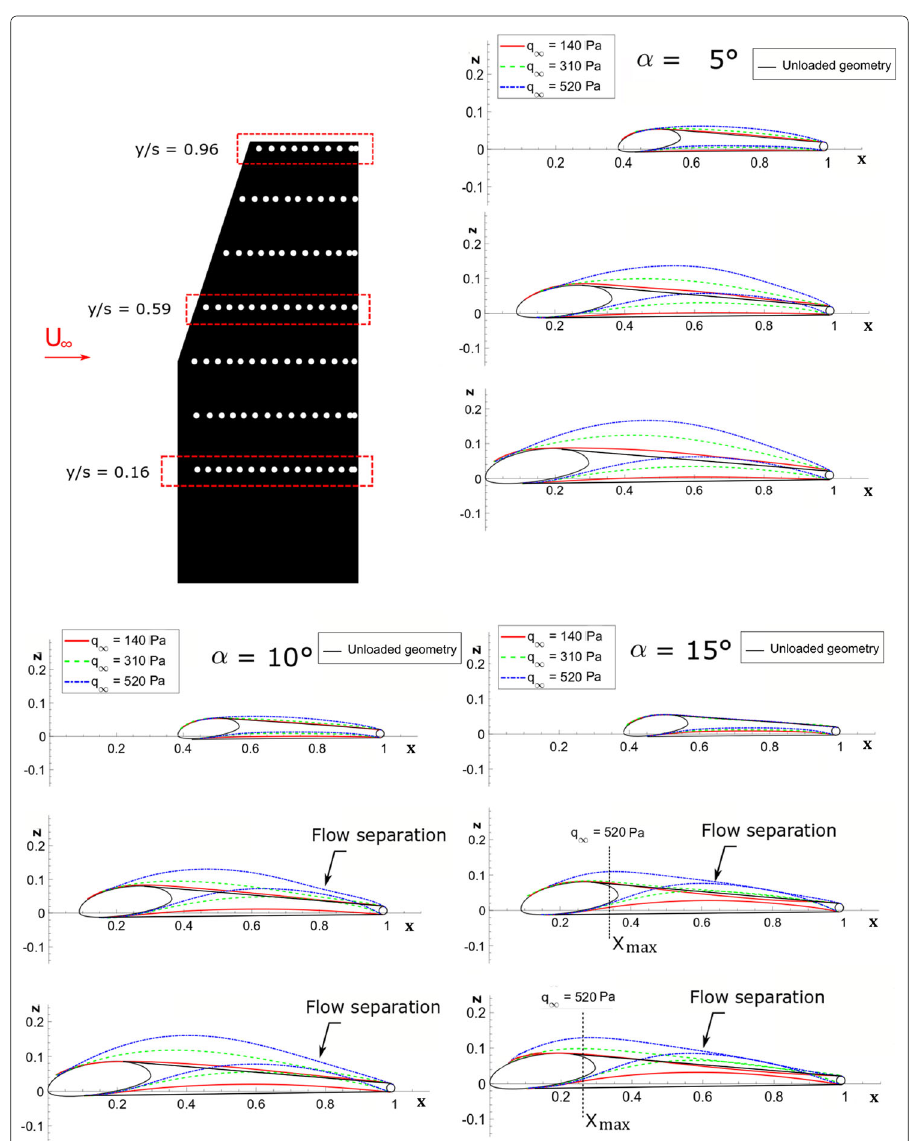
Fig. 7 Membrane deflection at α = 5, 10 and15 deg and q ∞ = 140, 310 and 520 Pa